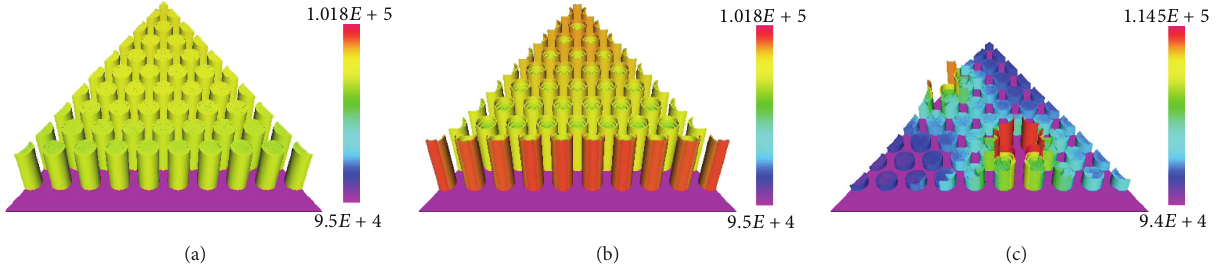
Figure 4: Burnup distribution at 100GWd/tHM for the reference case (a), the case with the moderating material in the wire wrapper (b), and the case with moderating material arranged in pins